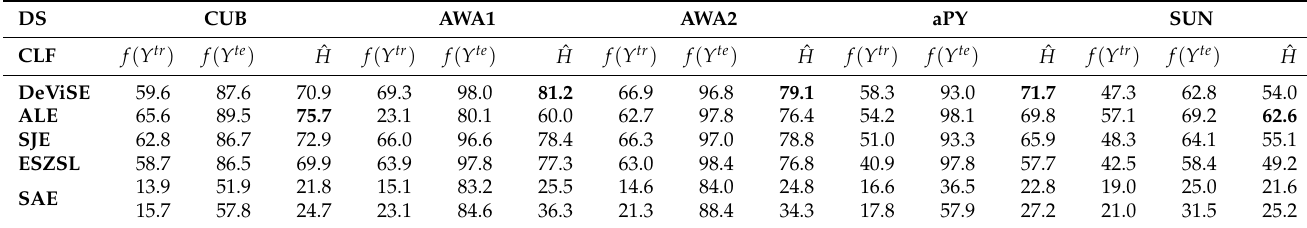
Table 5. Individual Classifier Results for the T5